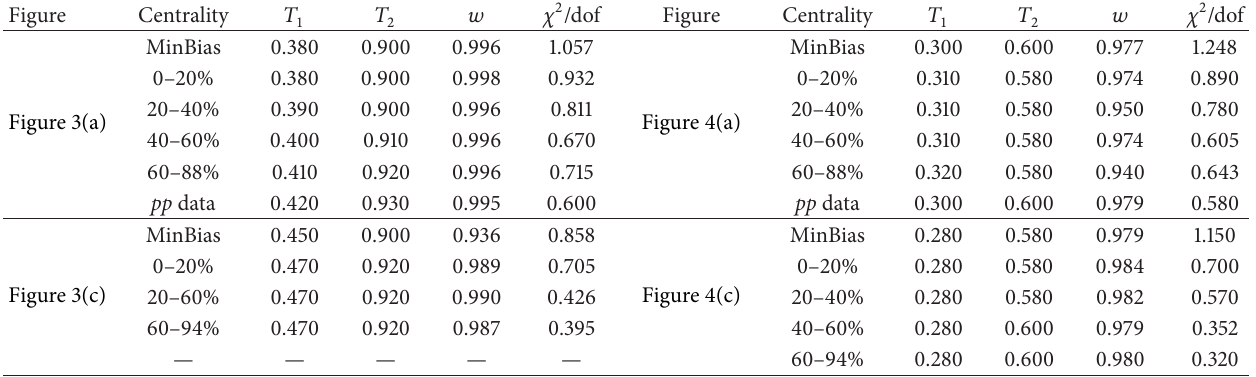
Table 3: Values of 𝑇 1 , 𝑇 2 , and 𝑤 taken in Figures 3 and 4. 𝑇 1 and 𝑇 2 units are